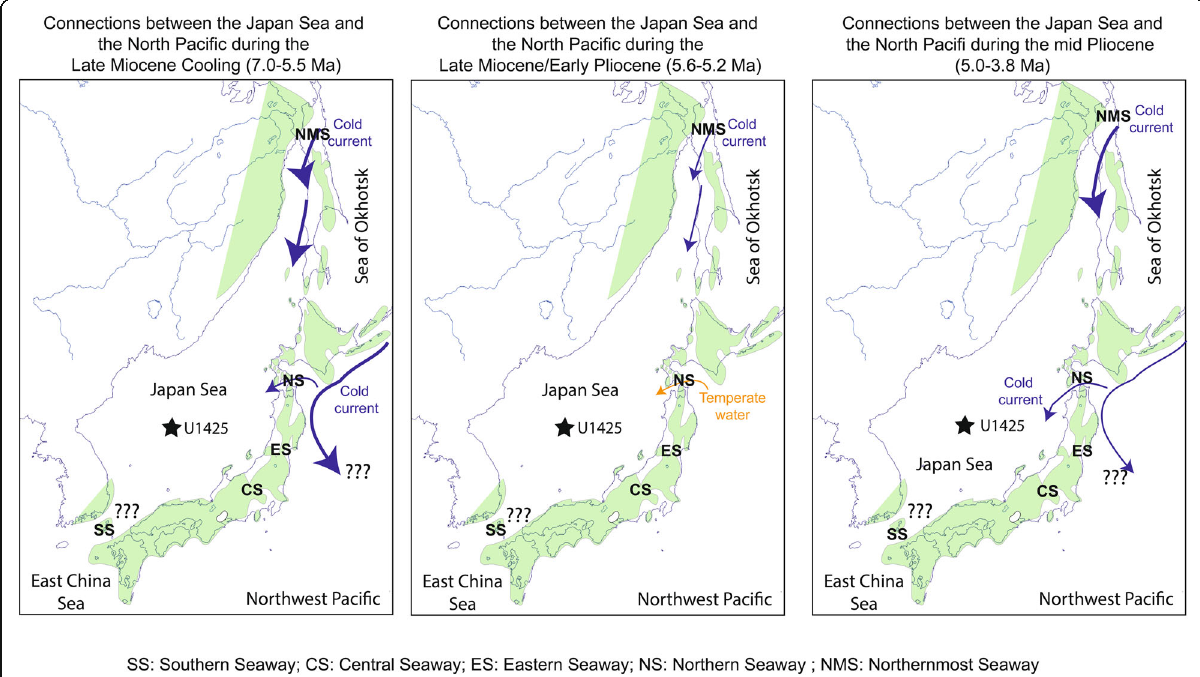
Fig. 8 Connections between the Japan Sea and the North Pacific during the late Miocene to late